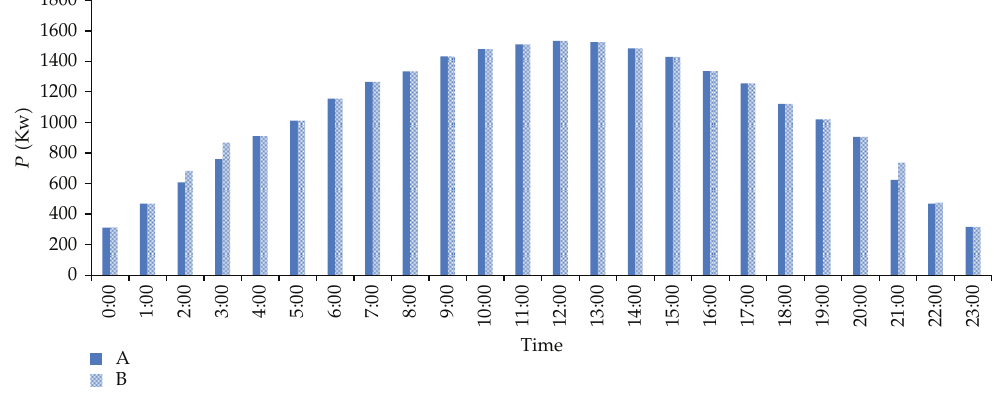
Figure 9: Input power of the di ff erent models.